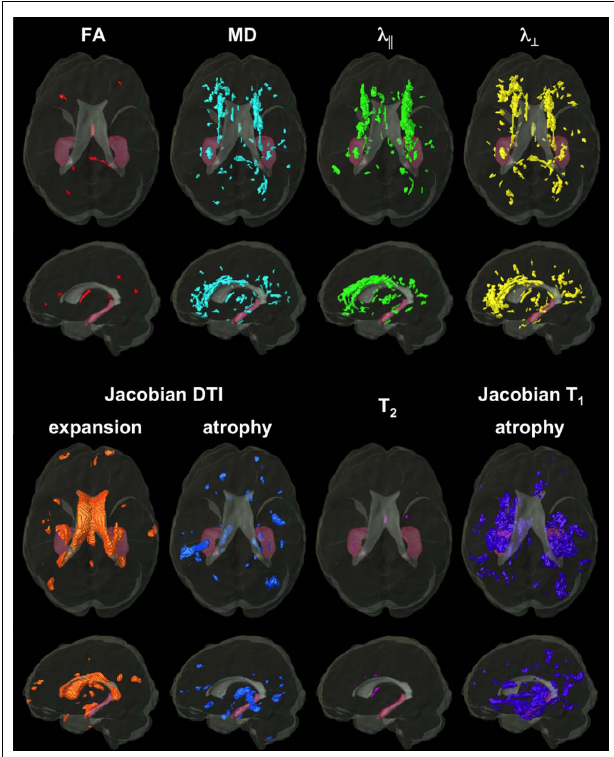
FIGURE 3 |Top and left-side view of the eight disease-specific spatial filters (DSFs) created from voxel-based statistical comparisons of the training dataset (AD and NC). The brain surface and the hippocampal surface of the JHU-MNI atlas are shown in gray and pink,